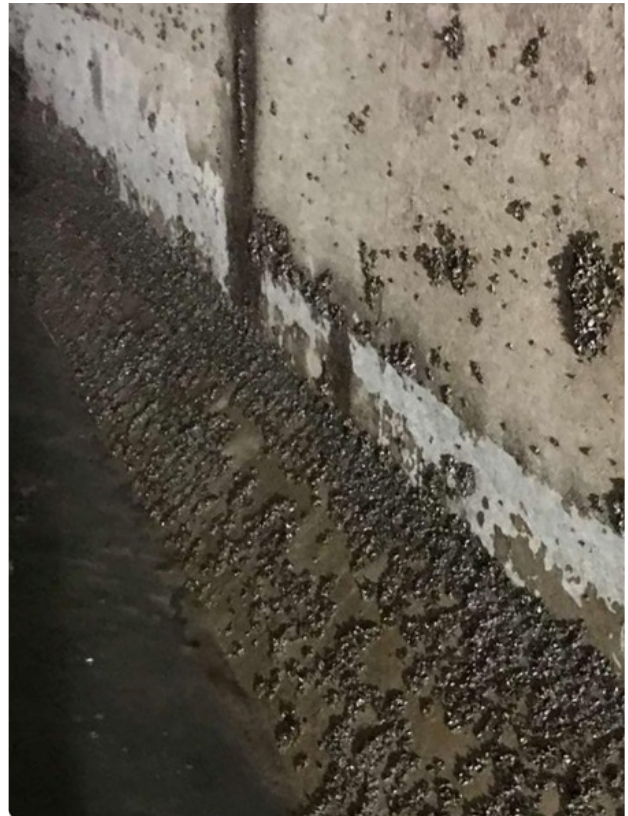
Figure 7. Freshwater mussels on an inverted siphon.